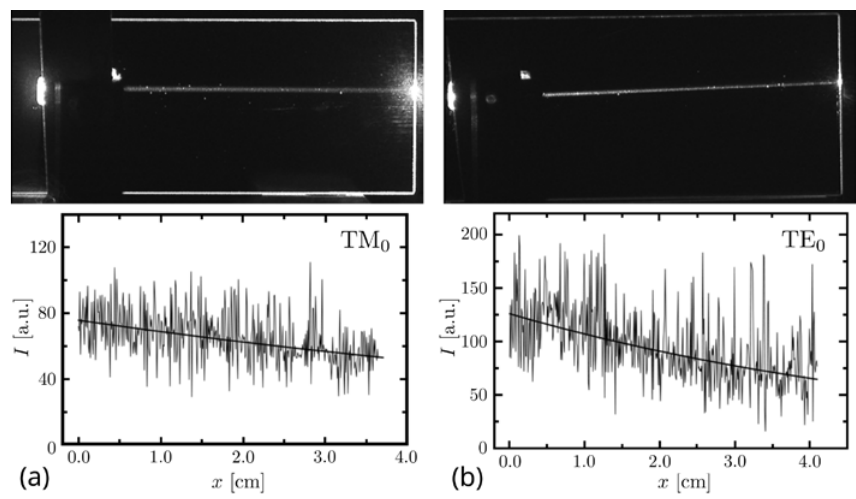
Figure 5. Demonstration of the light propagation in SiO 2 :TiO 2 WG films. Light intensity I is given in arbitrary units. A scattering streak of light (top) and its intensity profile (bottom)is shown for the TM ( a ) and TE ( b ) polarization.